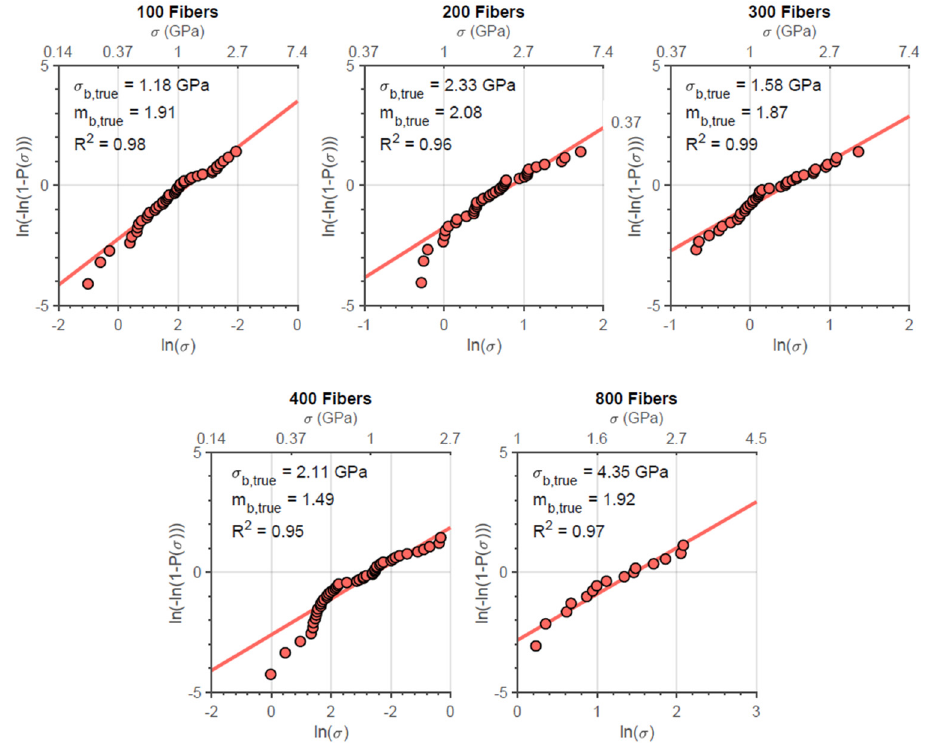
Figure 9. Weibull plots for N720 fiber bundles with different initial amounts of fibers.